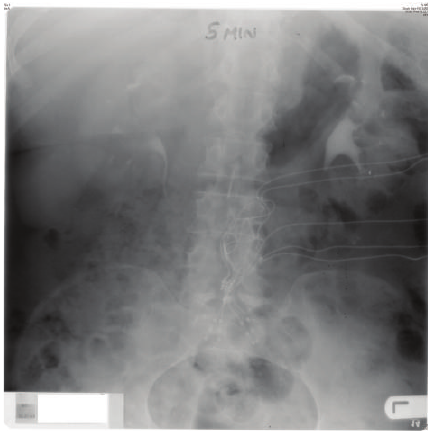
Figure 1: Case 1: five-minute film of intravenous urography, per- formed in December 2004, showing excretion of contrast by both kidneys with no hydronephrosis. The intradural and extradural electrodes of the sacral anterior nerve roots can be seen.